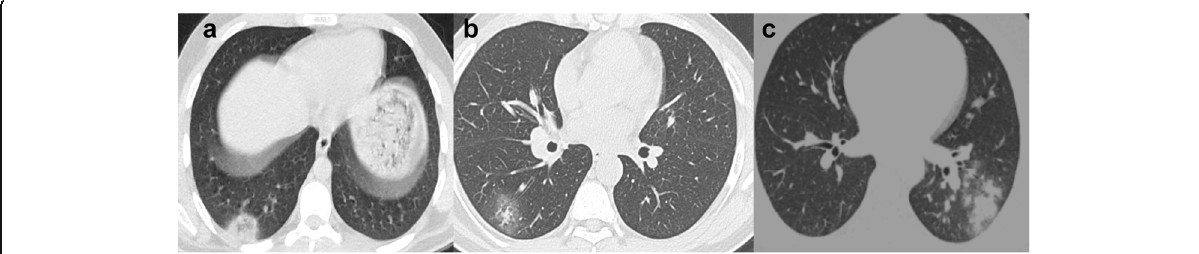
Fig. 4 Axial chest CT lung window in different cases with COVID-19 pneumonia showing a the reversed halo sign: right lower lobe posterior basal segment patchy consolidation with internal lucency. b Halo sign: patchy consolidation with a surrounding halo of ground-glass density at the right lower lobe apical segment ( b ) and at the left lower lobe ( c